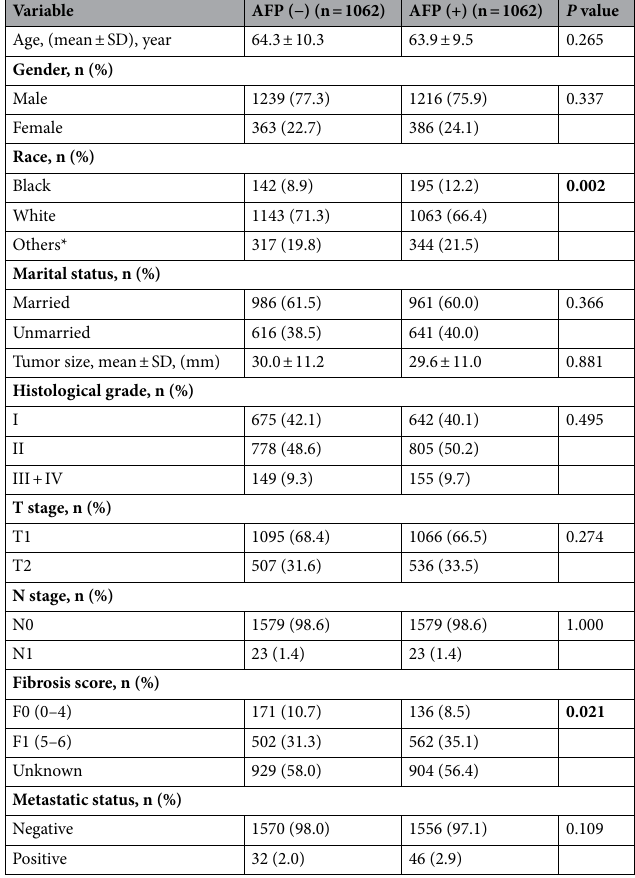
Table 3. Comparison of clinicopathological metrics between the AFP positive and negative groups in 2124 small HCC patients matched by propensity scores. Significant values are in bold. *The others comprise